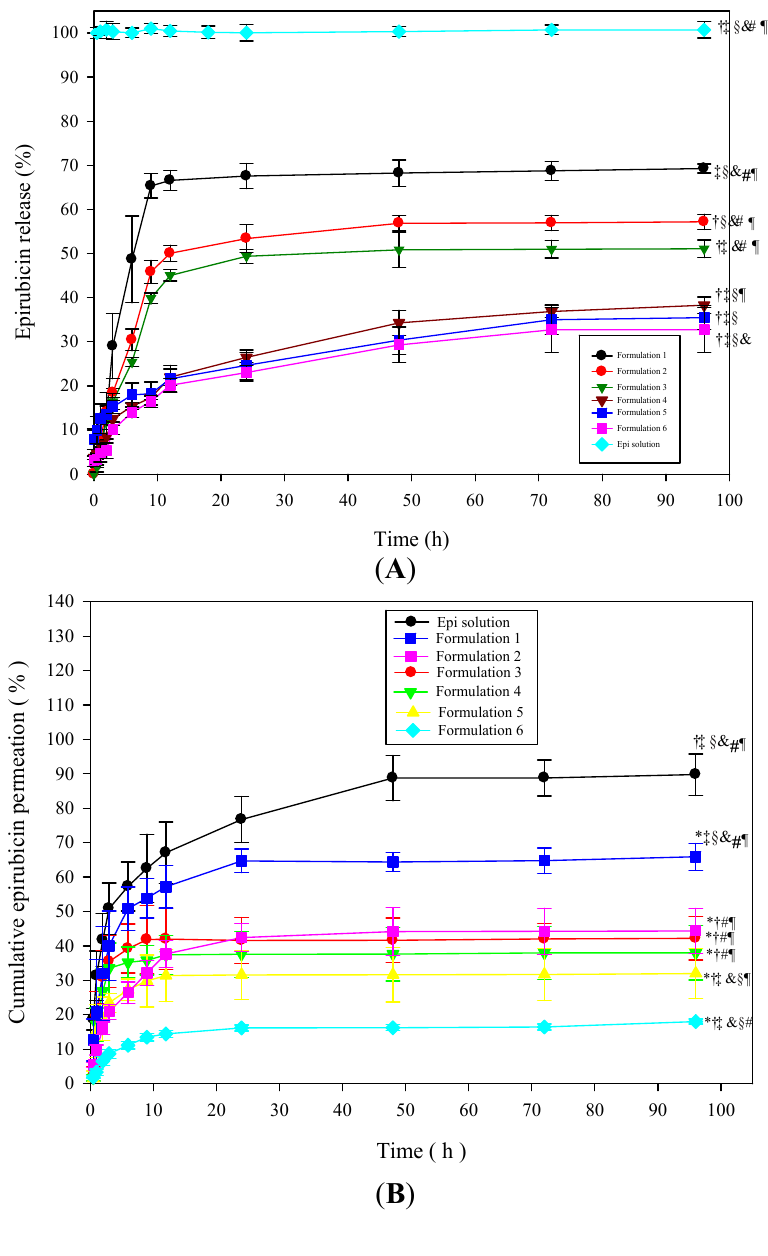
Figure 3. ( A ) In vitro release curves of Epi from Formulations 1–6 of liquid and solid suppositories; ( B ) Permeation percentage of Epi from different formulations through the SD rat rectums; and ( C ) Accumulation percentage of Epi from different formulations in the rat rectums. Data shown indicate means ± standard deviation (SD) of six